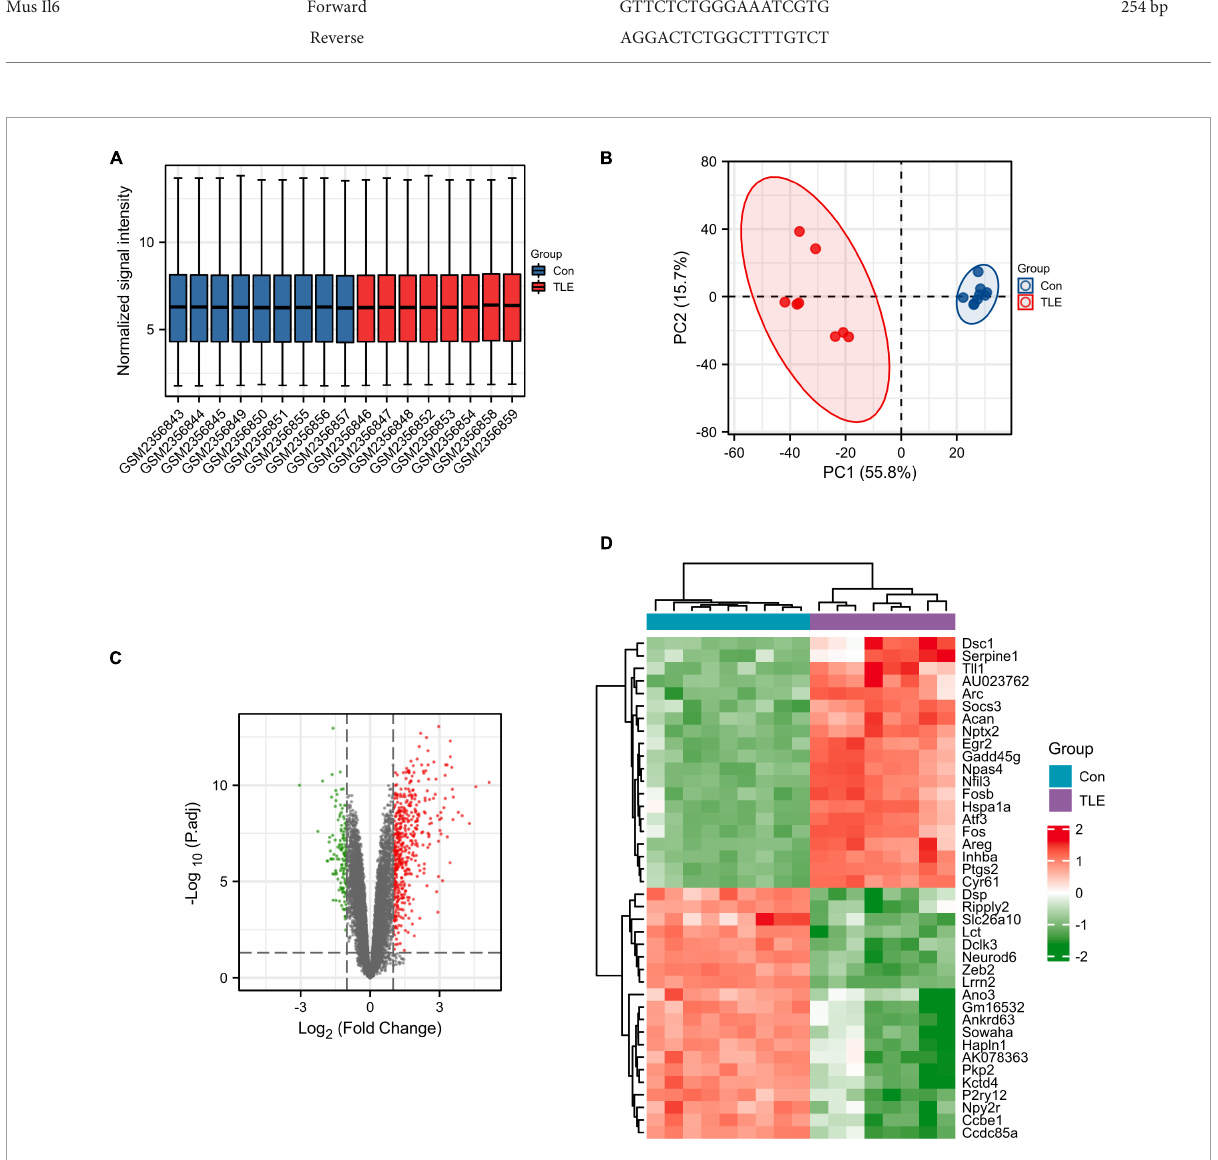
FIGURE1 Identification of DEGs in TLE. (A) Normalized data from control and TLE groups. (B) Principal component analysis for GSE88992. (C) Volcano plot of the DEGs (green dots represent 139 down-regulated genes, red dots represent 474 up-regulated genes). (D) Heatmaps of the top 40 DEGs in the GSE88992 dataset. Red indicates up-regulated and green indicates